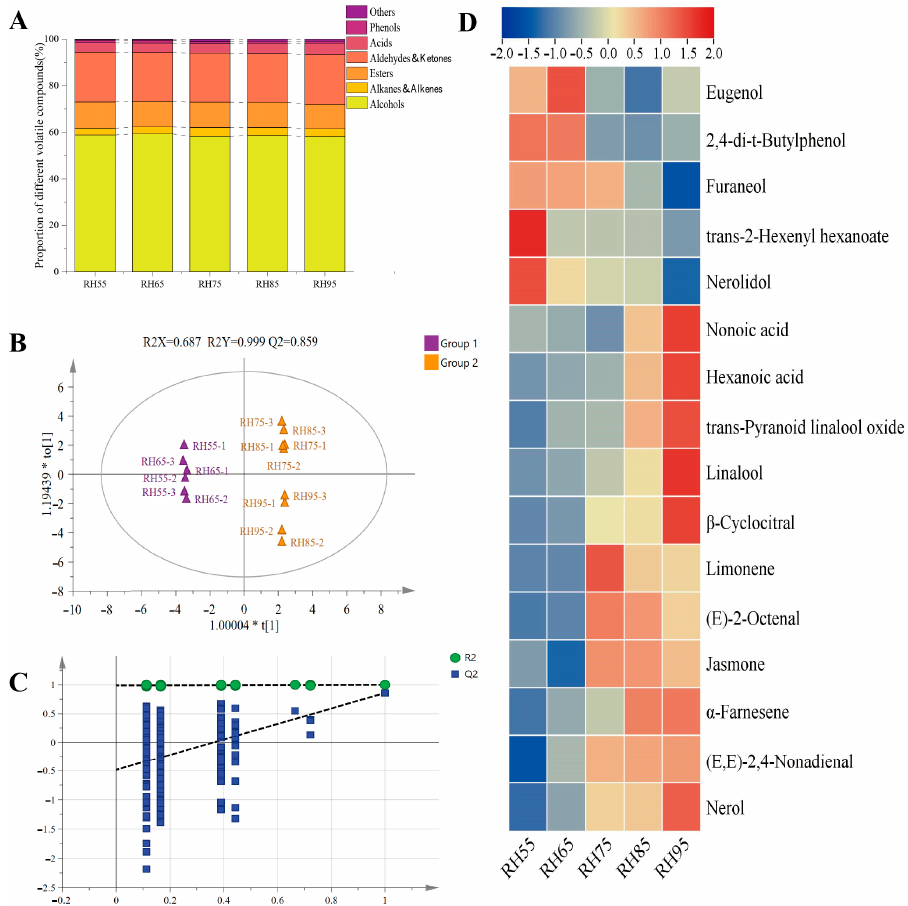
Table 2. E ff ect of fermentation humidity on the contents of di ff erent volatile species in congou black tea. (µg/g).